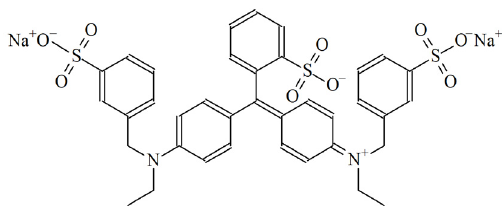
Figure 1. The chemical formulae of E133 Dye.